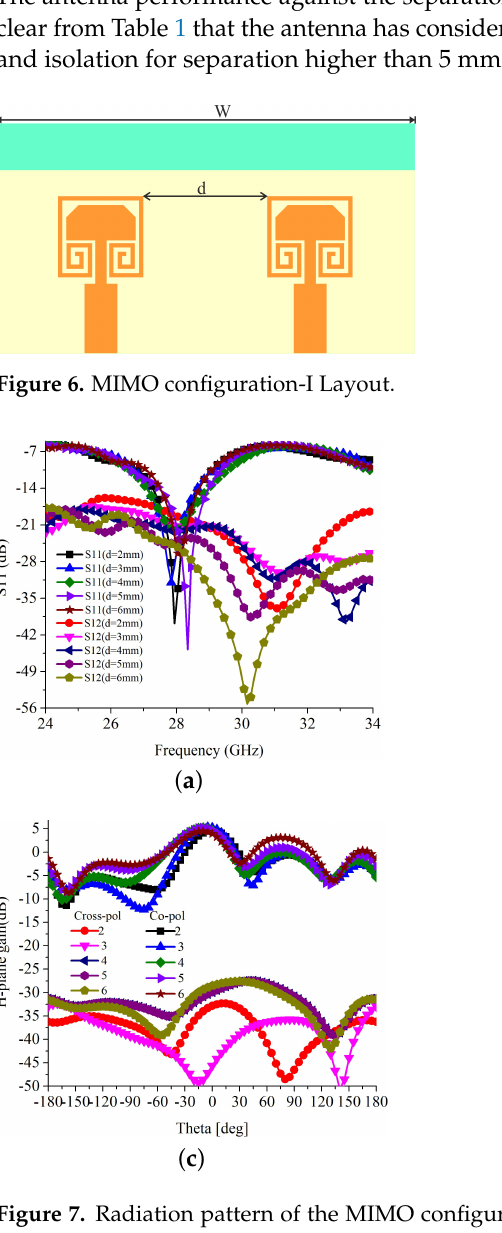
Figure 7. Radiation pattern of the MIMO configuration-I against separation ( d ) between antenna elements ( a ) S 11 and S 12 ; ( b ) E-plane; ( c )